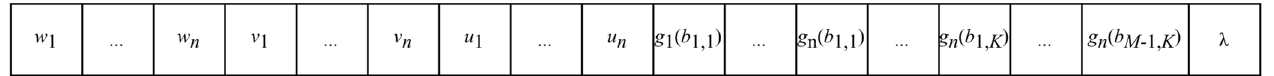
Figure 3. Individuals used in the genetic algorithm to represent 𝑛𝐶 (cid:3036)(cid:3041)(cid:3033) .